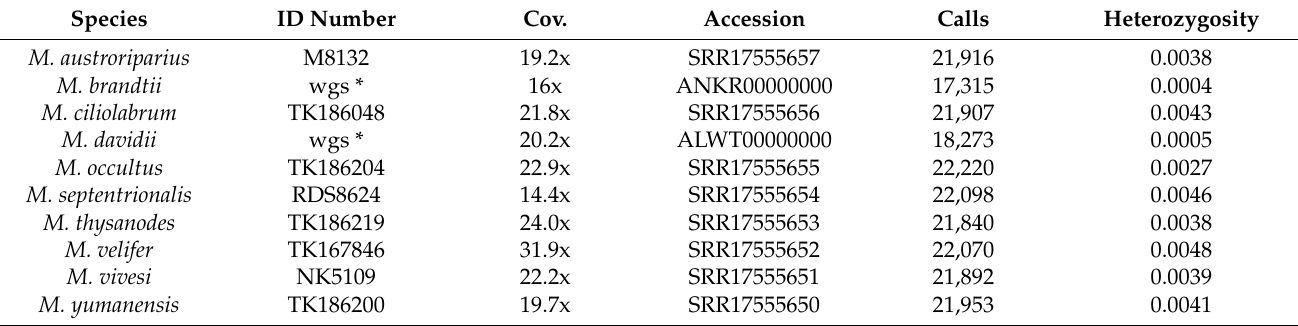
Table 1. Summary of Myotis whole genome sequences used in this project. The Cov. column refers to the average coverage of the M. lucifugus reference genome for that species. The Calls column refers to the number of Ves calls for each species after quality filtering. The accession column includes NCBI accession